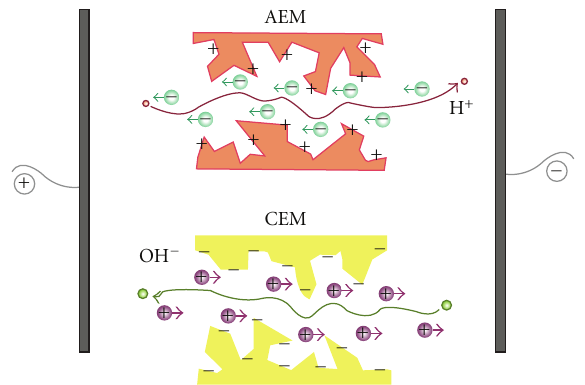
Figure 11: Schematic representation (o ff scale) of H + traversing an anion-exchange membrane (AEM) and the proposed counterpart for OH − hopping through mobile counterions in the cation- exchange membrane (CEM) in a working AFNOR-conditioned Sicopion ED stack.